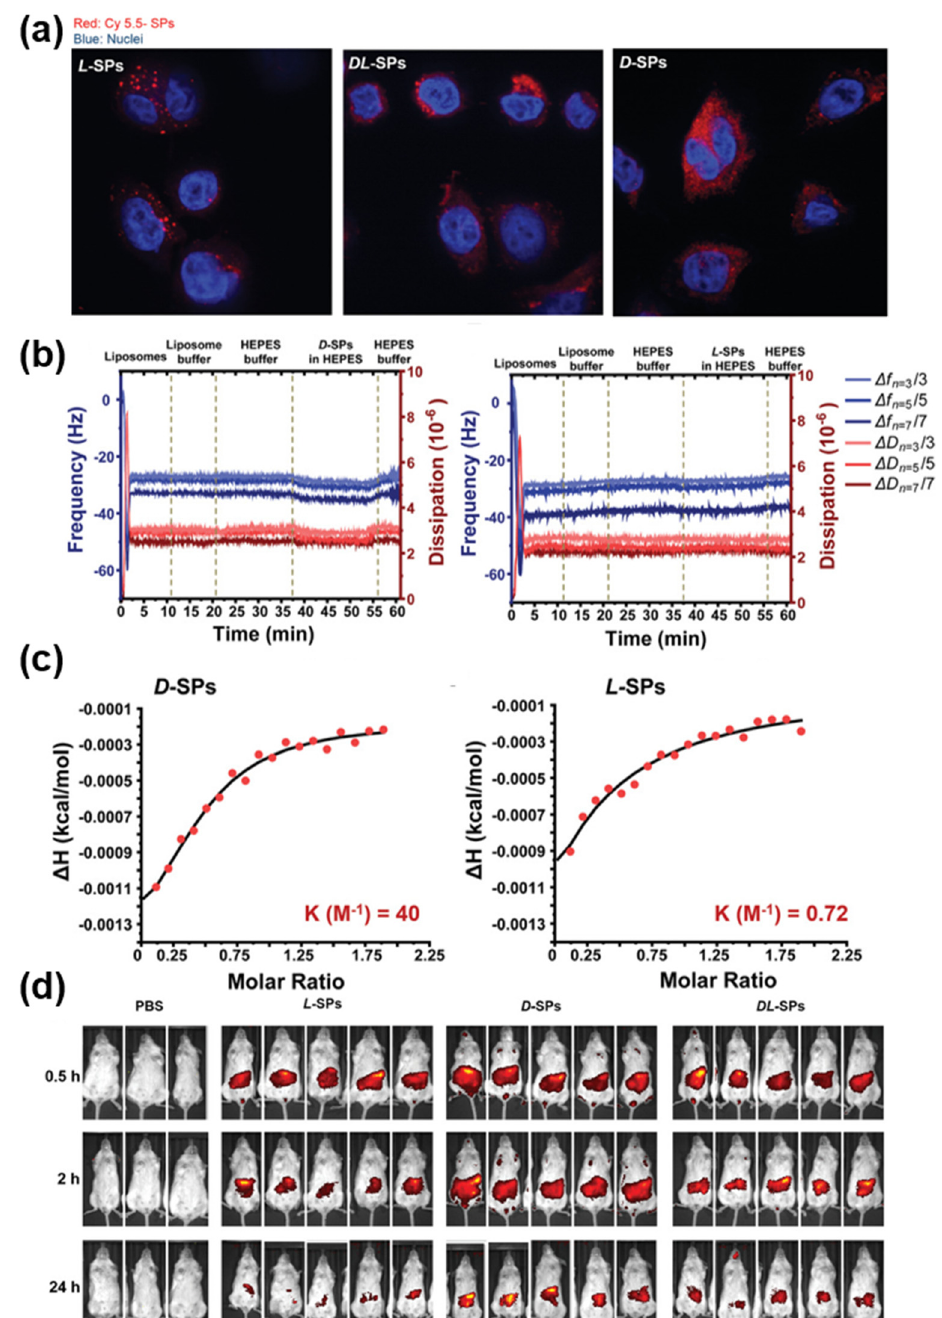
Figure 2. ( a ) Confocal images of HeLa cell nuclei (blue) and internalized D- , L- and DL- SPs (red). ( b ) QCM-D monitoring of D- and L- SPs’ adhesion on lipid bilayers. ( c ) ITC experiments for D- and L- SPs in liposome dispersions. ( d ) In vivo imaging system images of mice after intravenous injection of phosphate-buffered saline, L- , D- and DL- SPs. Reprinted with permission from Ref. [19]. Copyright 2019 John Wiley and Sons.